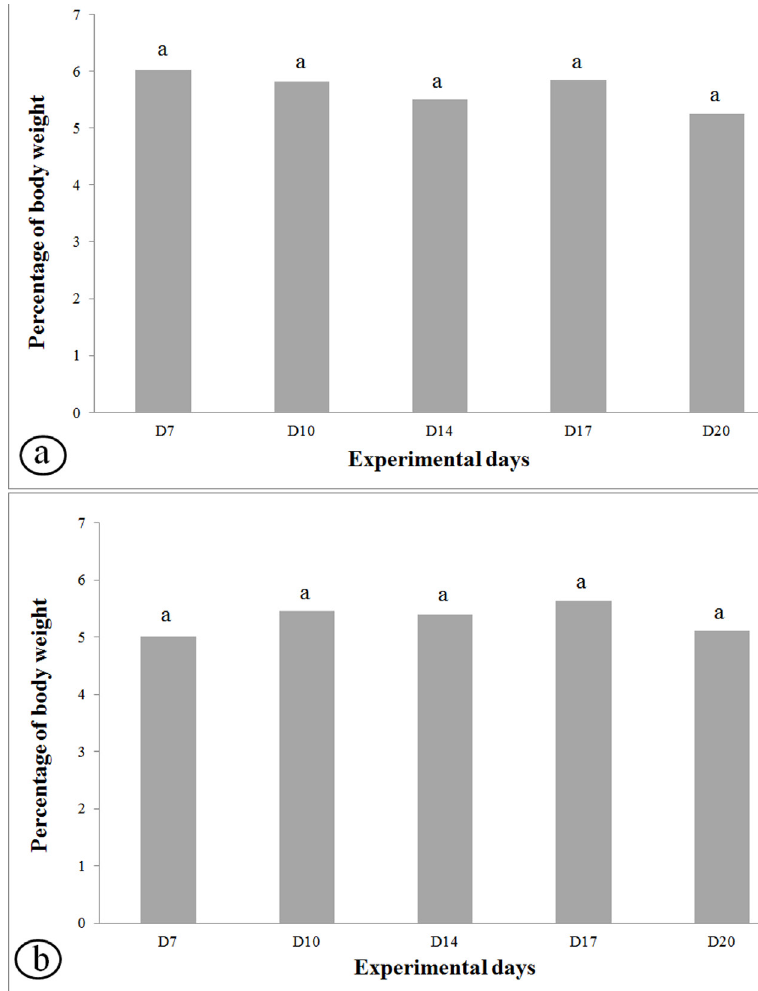
Figure 3 - Load equivalent to anaerobic threshold of non-pregnant and pregnant rats during swimming lactate minimum (LacMin) test in diferente days of experiment ( a ) and pregnancy ( b ). n=5 animals/group. Means followed by similar lowercase letters show no statistical difference